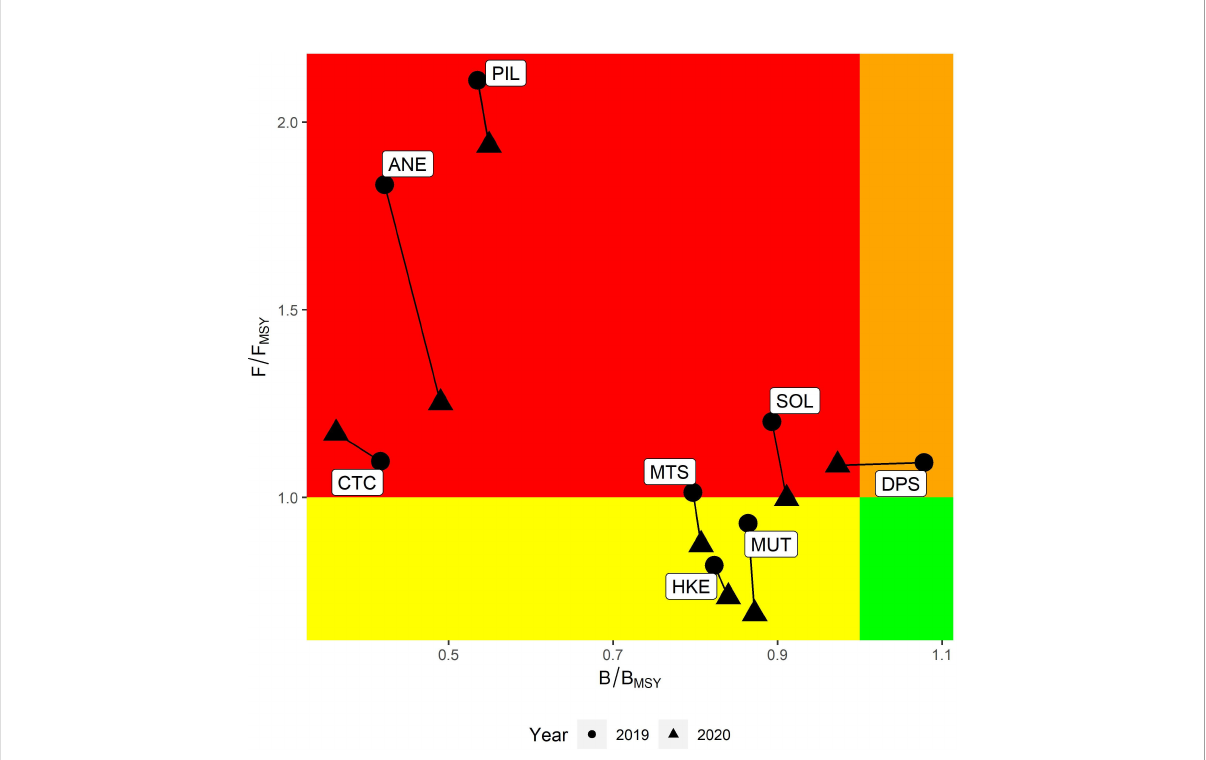
FIGURE 3 Kobe plot showing the outputs of CMSY/BSM of eight Adriatic Sea target stocks in 2019 (triangle) and 2020 (circle). Lines link the outputs for the same species in different